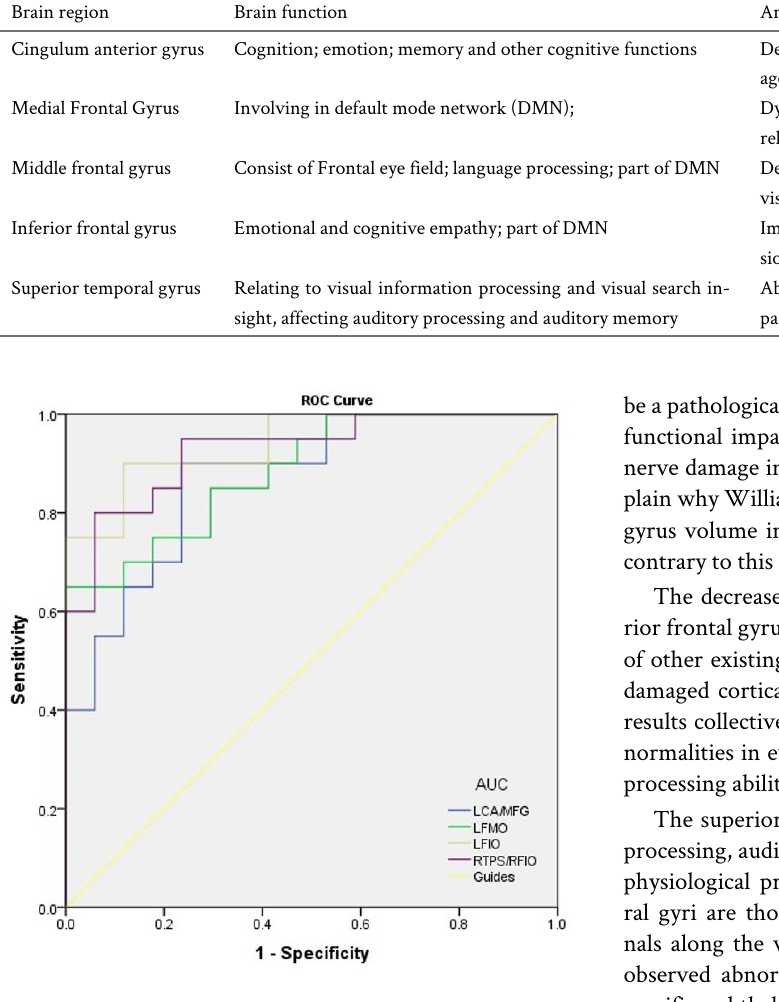
Fig. 4. ROC curve of the VBM values in altered brain areas. The area under the ROC curve were 0.871 ( p < 0.0001; 95% CI: 0.758–0.984) for LCA/MFG, LFMO 0.885 ( p < 0.0001; 95% CI: 0.783–0.988), LFIO 0.941 ( p < 0.0001; 95% CI: 0.871–1.000), RTPS/RFIO 0.926 ( p < 0.0001; 95% CI: 0.845–1.000). AUC, area under the curve; ROC, receiver operating charac- teristic; CI, confidence interval; LCA/MFG, left anterior Cingulum/Medial Frontal Gyrus; LFMO, left middle frontal gyrus, orbital part; LFIO, left in- ferior frontal gyrus, orbital part; RTPS/RFIO, right temporal pole: superior temporal gyrus/right inferior frontal gyrus, orbital